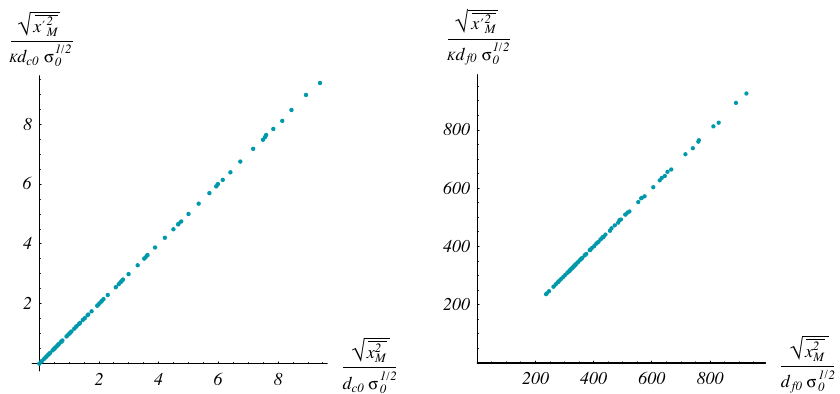
FIG. 2. (Color) Phase space motion of the normalized rms lateral displacement and angular divergence of a finite train of pointlike bunches at the exit of a representative linear collider due to misalignment of the cavities (left) or focusing elements (right). See Table I for the choice of